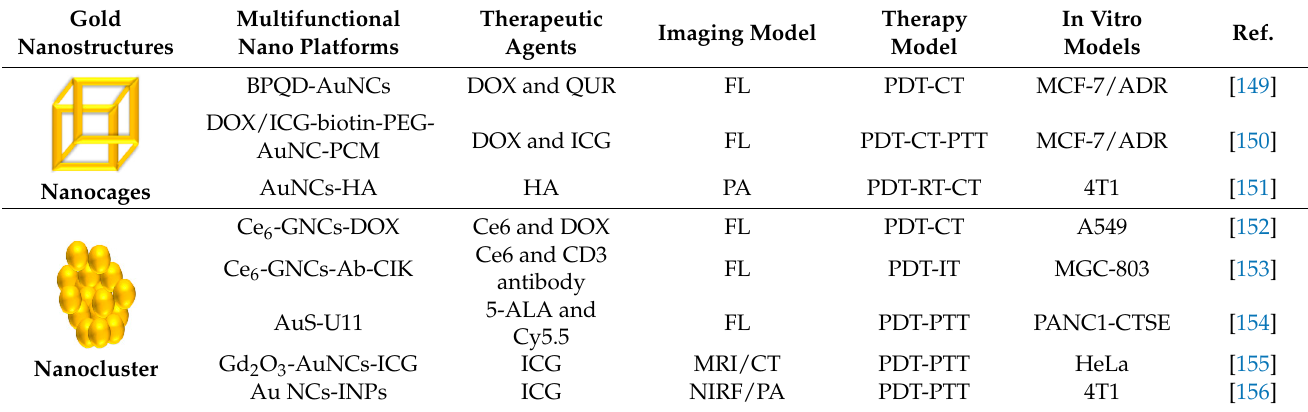
Table 5. The summary of the therapeutic aids of various gold nanostructures for synergetic photo- therapies for cancer theranostics.